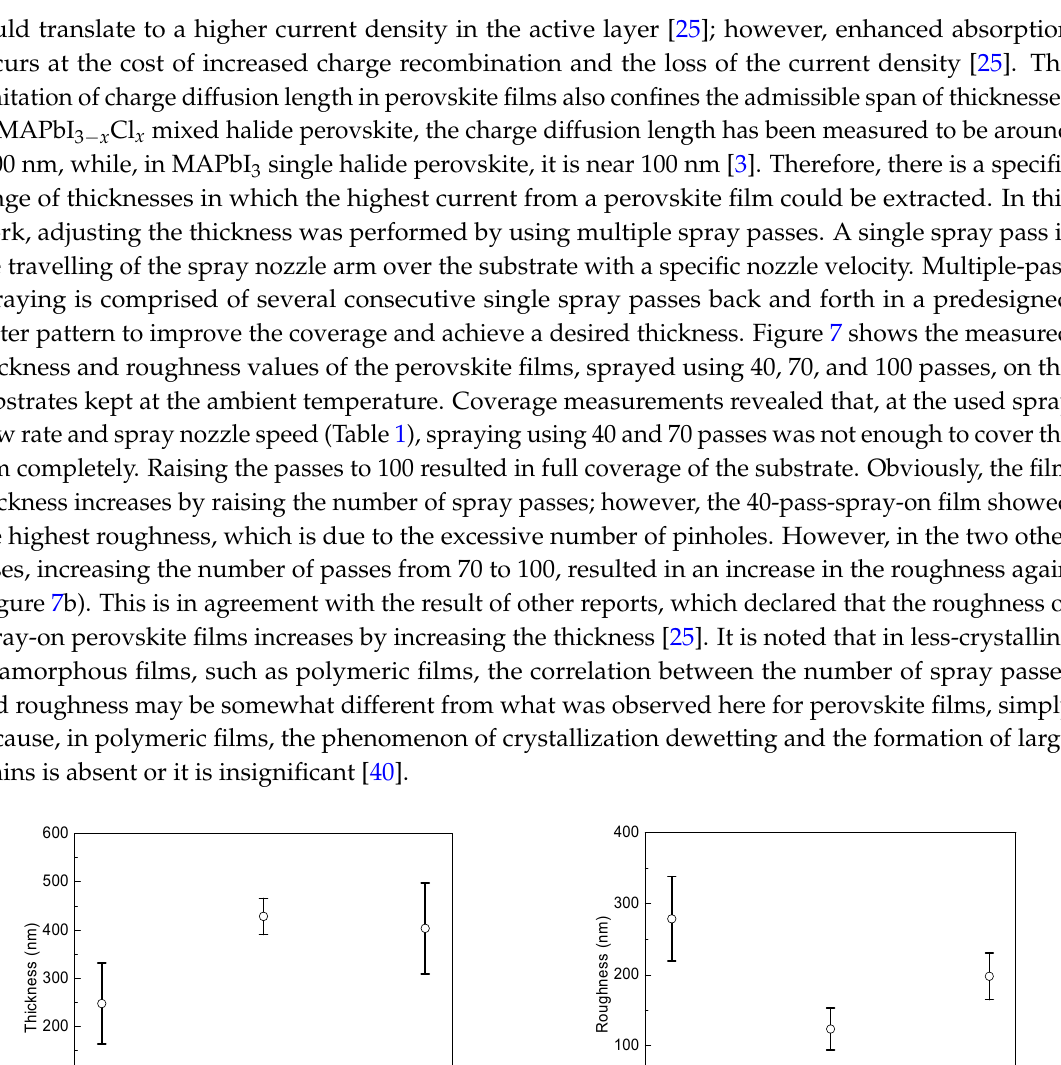
( b ) Figure 8. Measured ( a ) thickness and ( b ) roughness of spray-on perovskite films deposited on the substrates kept at 150 °C, at various number of spray passes. Figure 9 shows the SEM images of spray-on perovskite films deposited on the hotplates kept at 150 °C, while the number of passes varies. The average coverage, denoted as C on the images, obtained from the SEM images, reveals that a fully-covered film was obtained after 100 passes. The coverage was obtained by image processing using the ImageJ software (version 1.51j, National Institutes of Health (NIH), Bethesda, MD, USA).